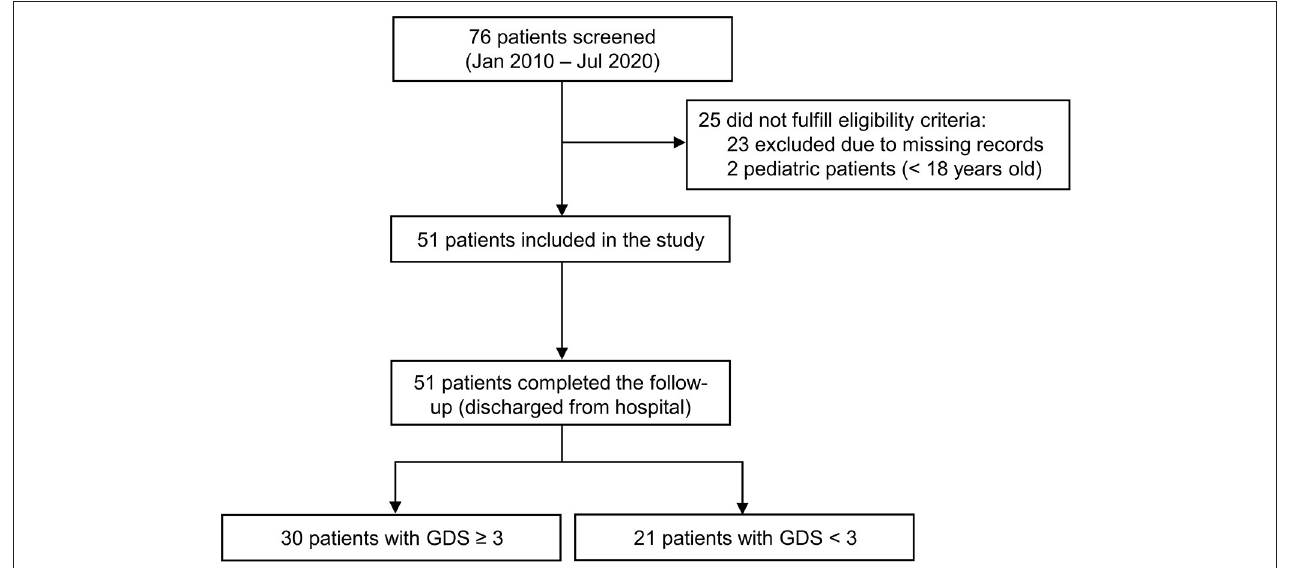
FIGURE 1 | Study flow-chart. All adult patients with GBS spectrum and complete clinical information from medical records were included.